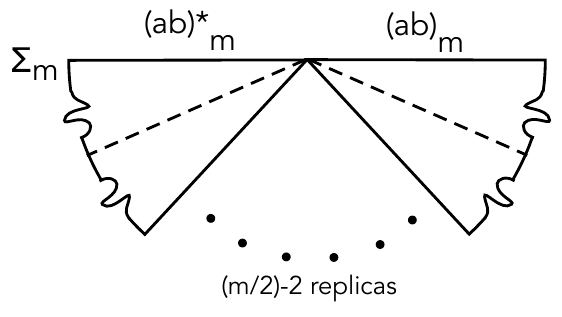
Figure 10 . The “ m/ 2 ” replicas placed below the entanglement wedges ( ab ) m and ( ab ) ?